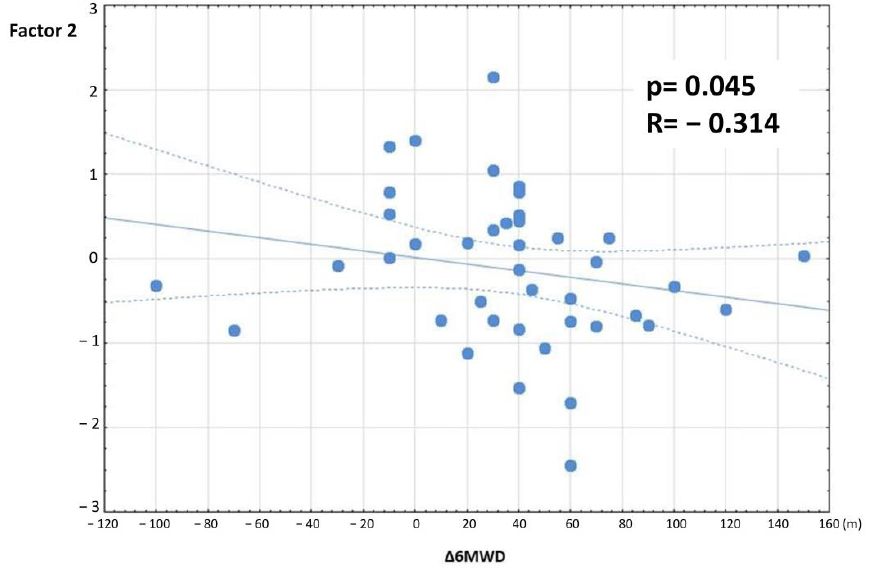
Figure 7. Relationship between Factor 2 and change in the 6MWD ( ∆ 6MWD) in the study group. Factor values were obtained by factor analysis of baseline FOT measurements in rehabilitated patients. Factor 2 reflects mostly reactance and Fres values (see Figure 3).